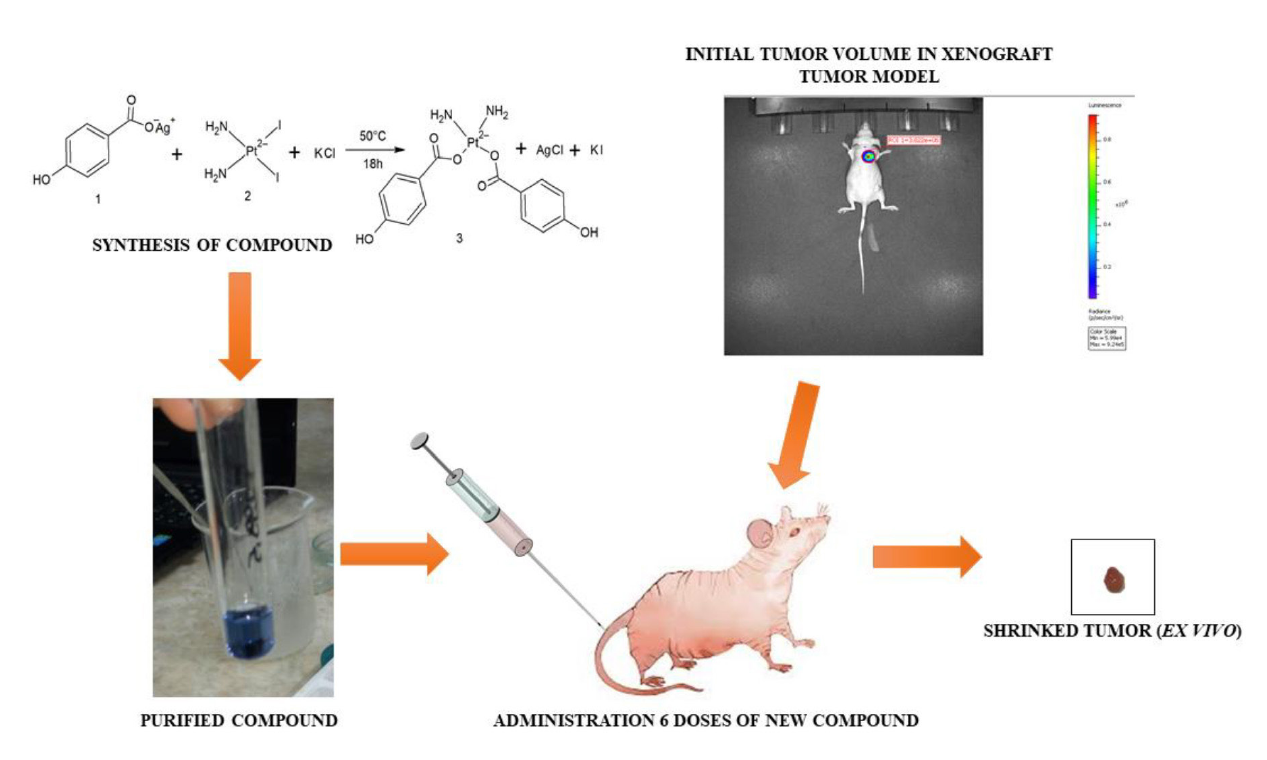
FIGURE 1 - Schematic illustration of the study. Synthesized new compound purified before in vitro and in vivo studies. Xenograft tumor model was created with A549-Luc cells in 5-6 weeks old Balb/c female nude mice, and tumor volumes were monitored during the study. After six doses of new compound administration, tumor volume decrease